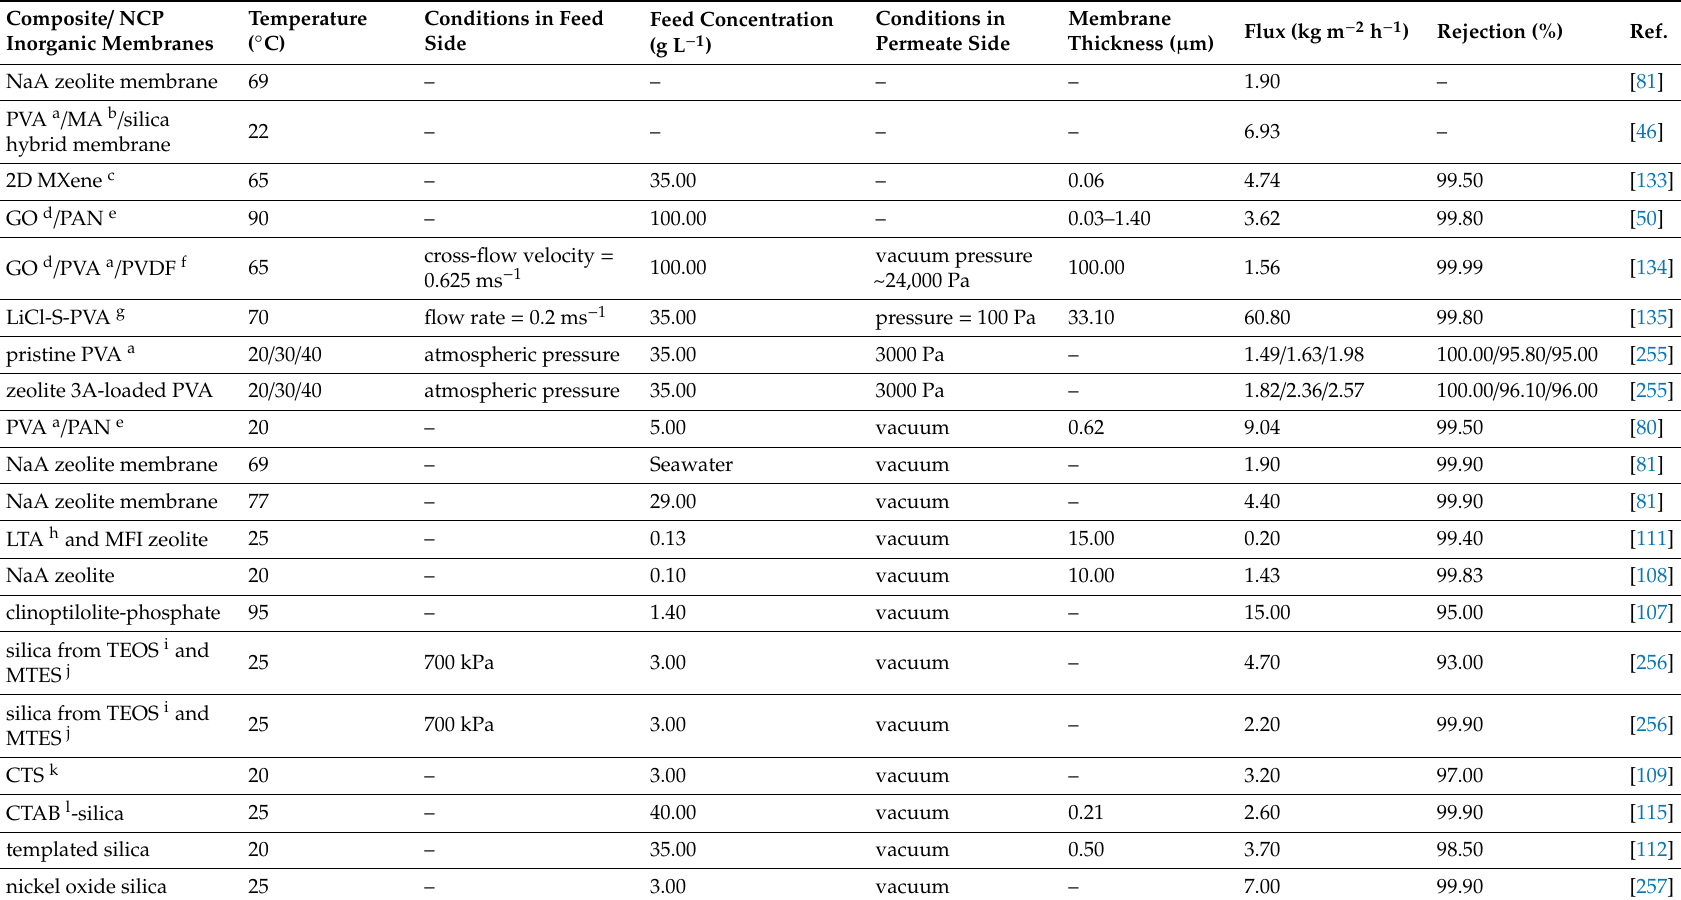
Table 4. Performances of composite / NCP inorganic membranes in pervaporative